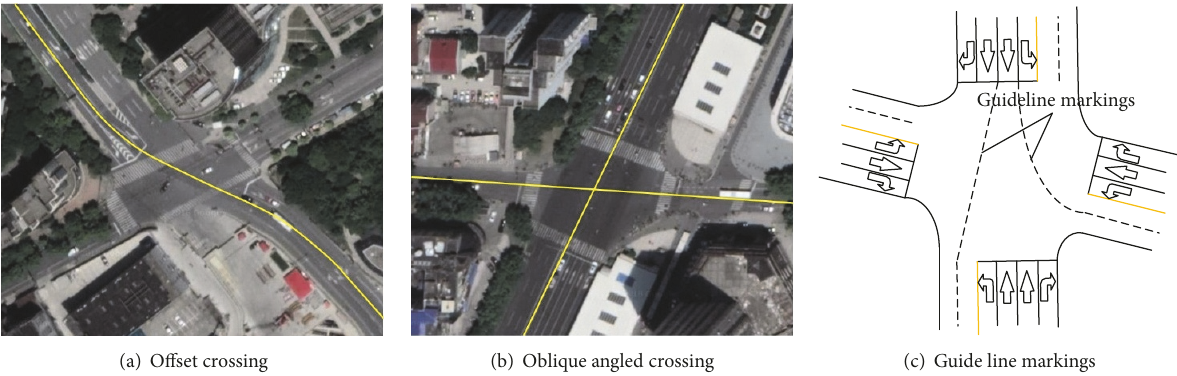
Figure 1: Irregular intersections and